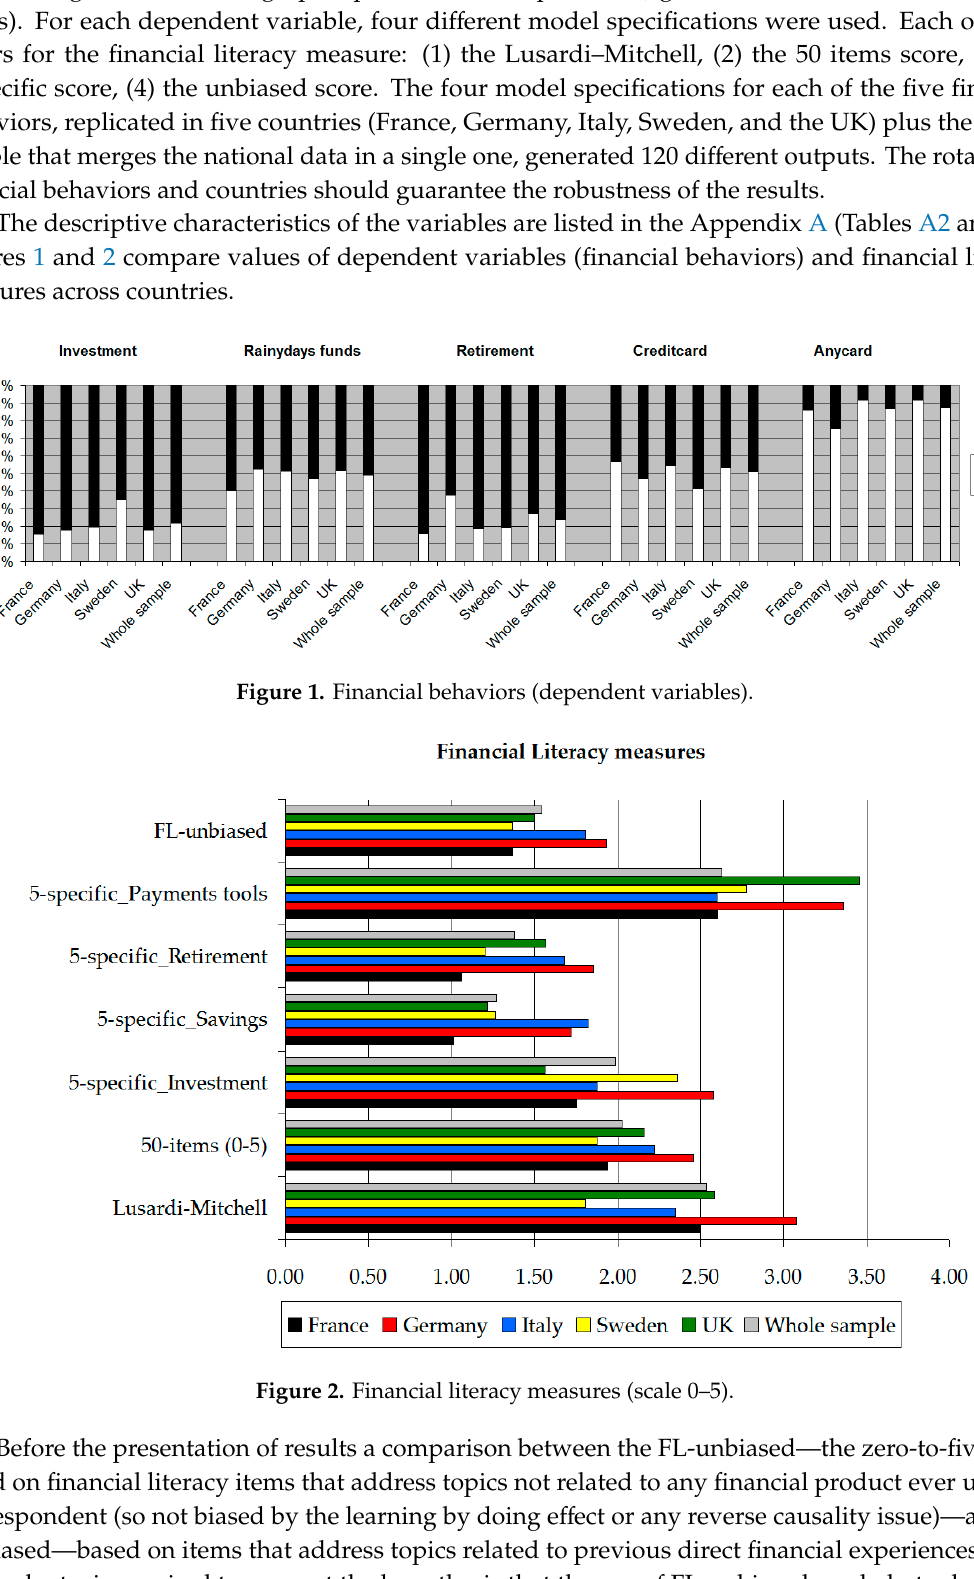
Table 2 . Biased- and unbiased-financial literacy measures. Obs .